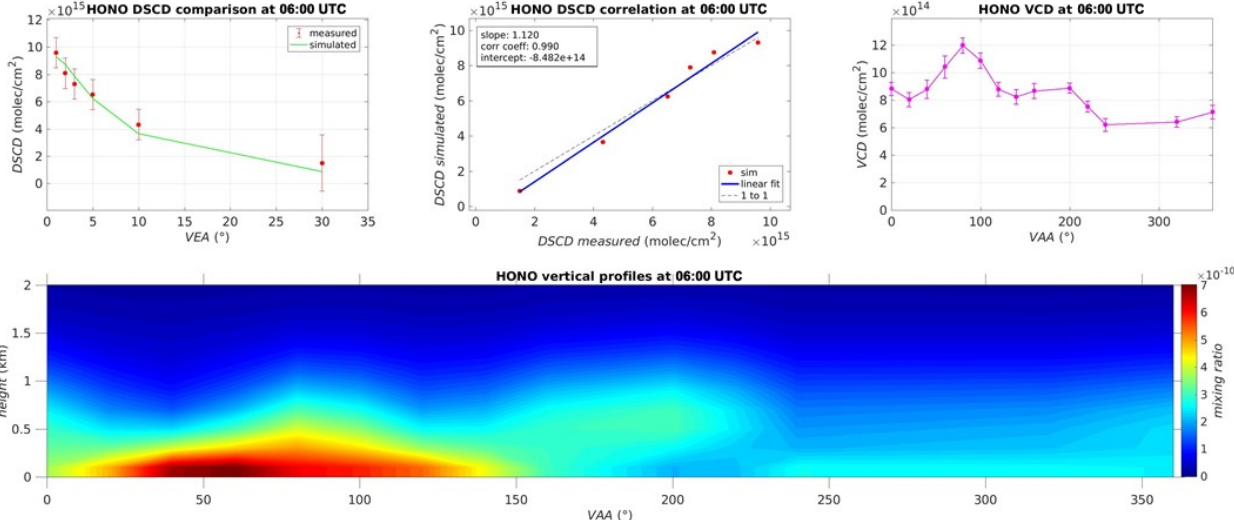
Figure 9. HONO vertical distribution retrieved in the UV region at 06:00UTC. These contour plots are smoothed from adjacent VAA data points separated by 20 ◦ in order to estimate the azimuthal distribution of HONO over